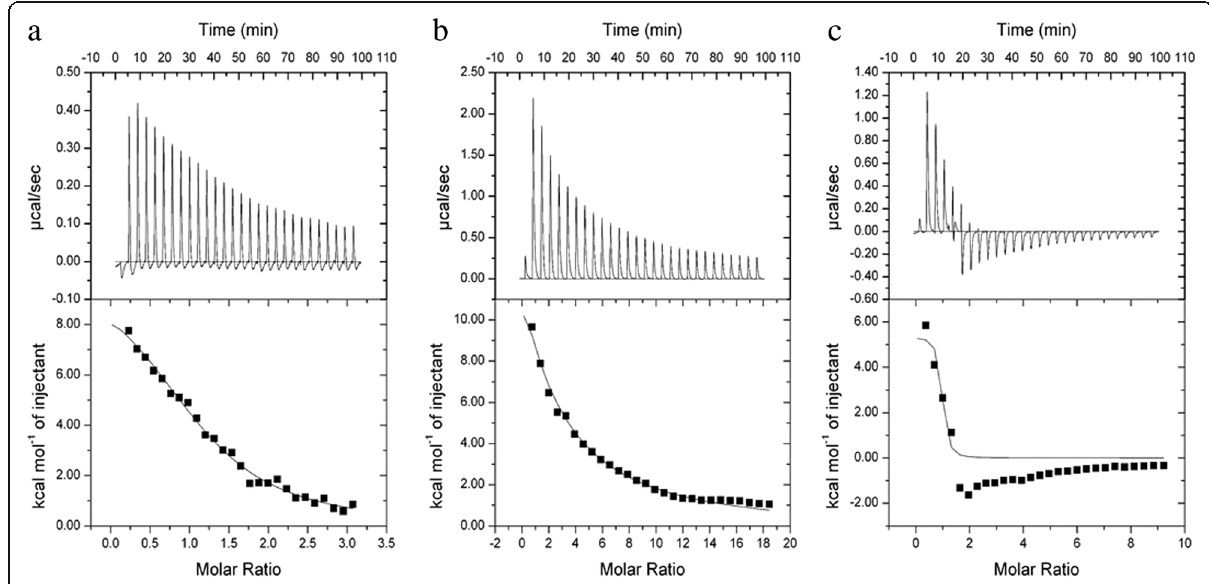
Fig. 5 Isothermal titration calorimetry data for HSA titration into a CHP, b CHSP, and c CHAP NPs at 25 °C. NP concentration in the cell (250 μ L) was 12 μ M and the protein concentration in the syringe was 230 μ M. Upper graphs show raw data, and lower graphs show integrated heats